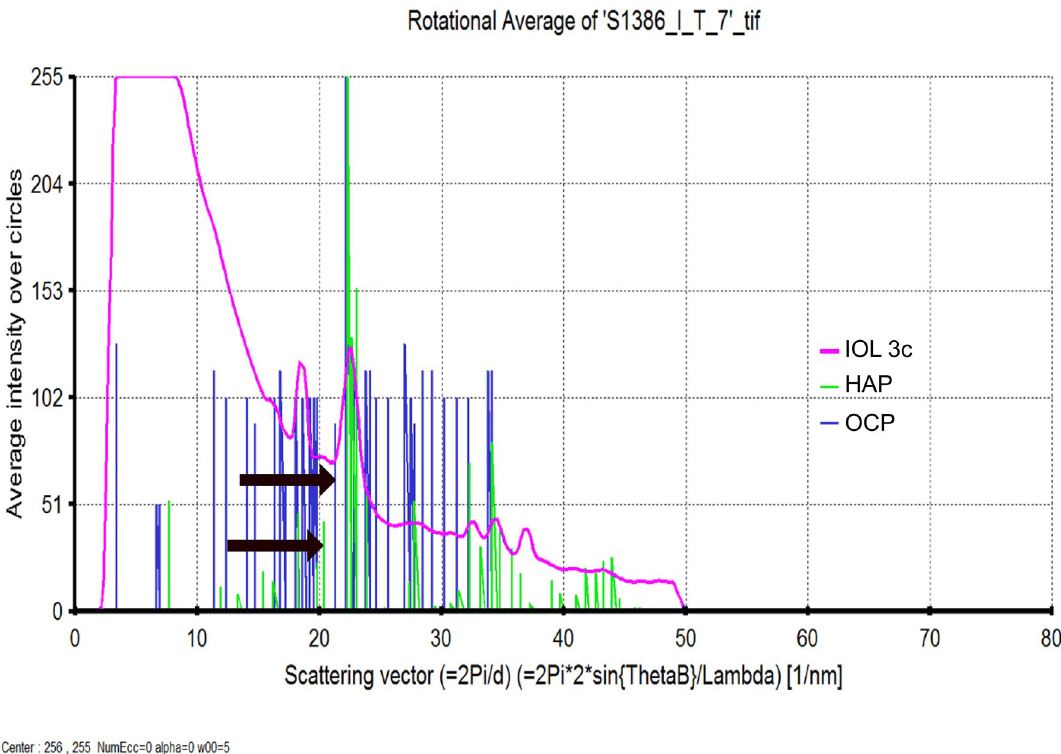
Figure 7. Distinction between crystals formed within the IOL polymer and hydroxyapatite (HAP) to octacalcium phosphate (OCP). Due to the OCP’s asymmetrical crystal structure, the reference electron diffraction (ED) pattern of OCP shows various diffraction reflections. These reflections are missing in the ED pattern of crystals in IOL 3c. Characteristic reflections to clearly distinguish OCP and HAP are marked